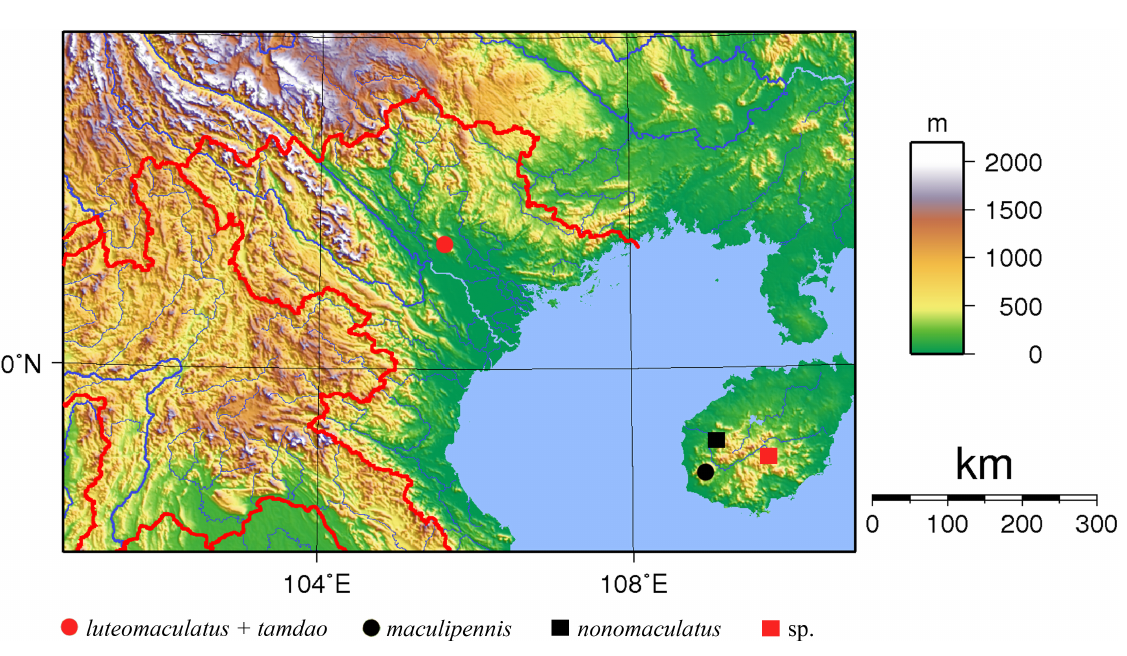
Fig. 1. Distribution map of the species of Gergithus (Maculergithus) subgen. nov. in North Vietnam and